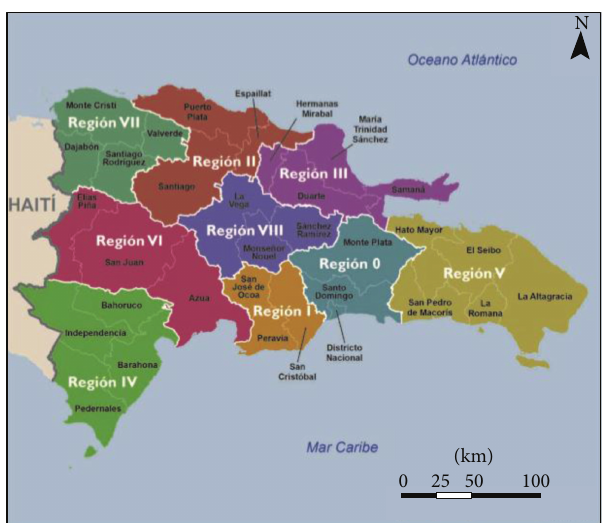
Figure 1: Regional map of Dominican Republic, adopted from the DRDHS,